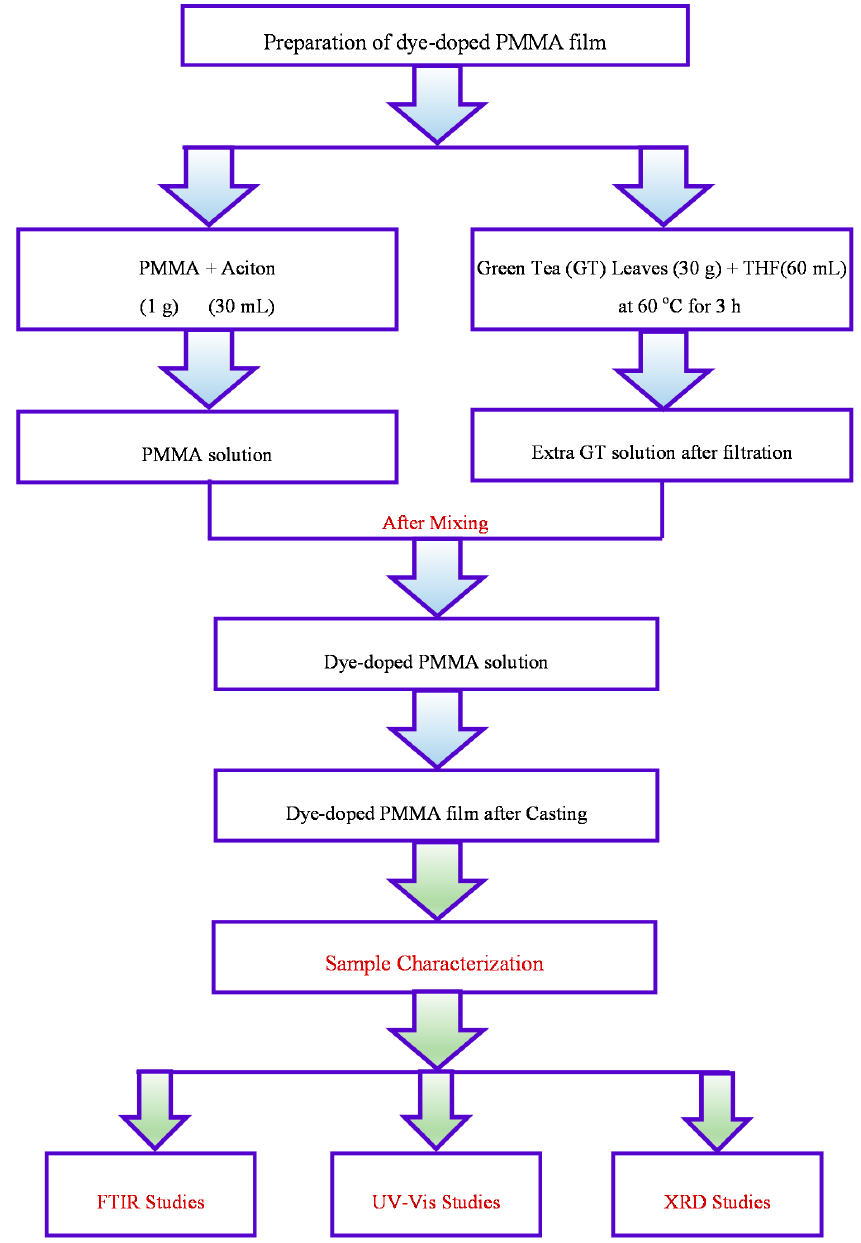
Figure 1. Flowchart of the experimental method and characterization techniques.